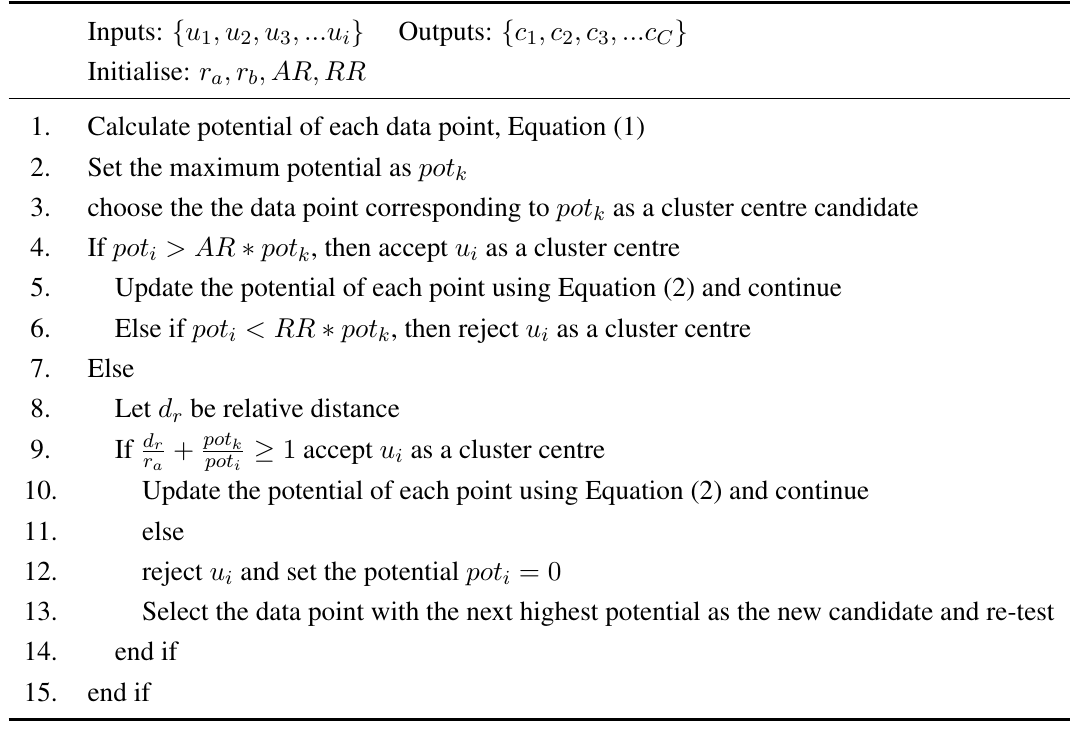
Algorithm 1. Subtractive clustering